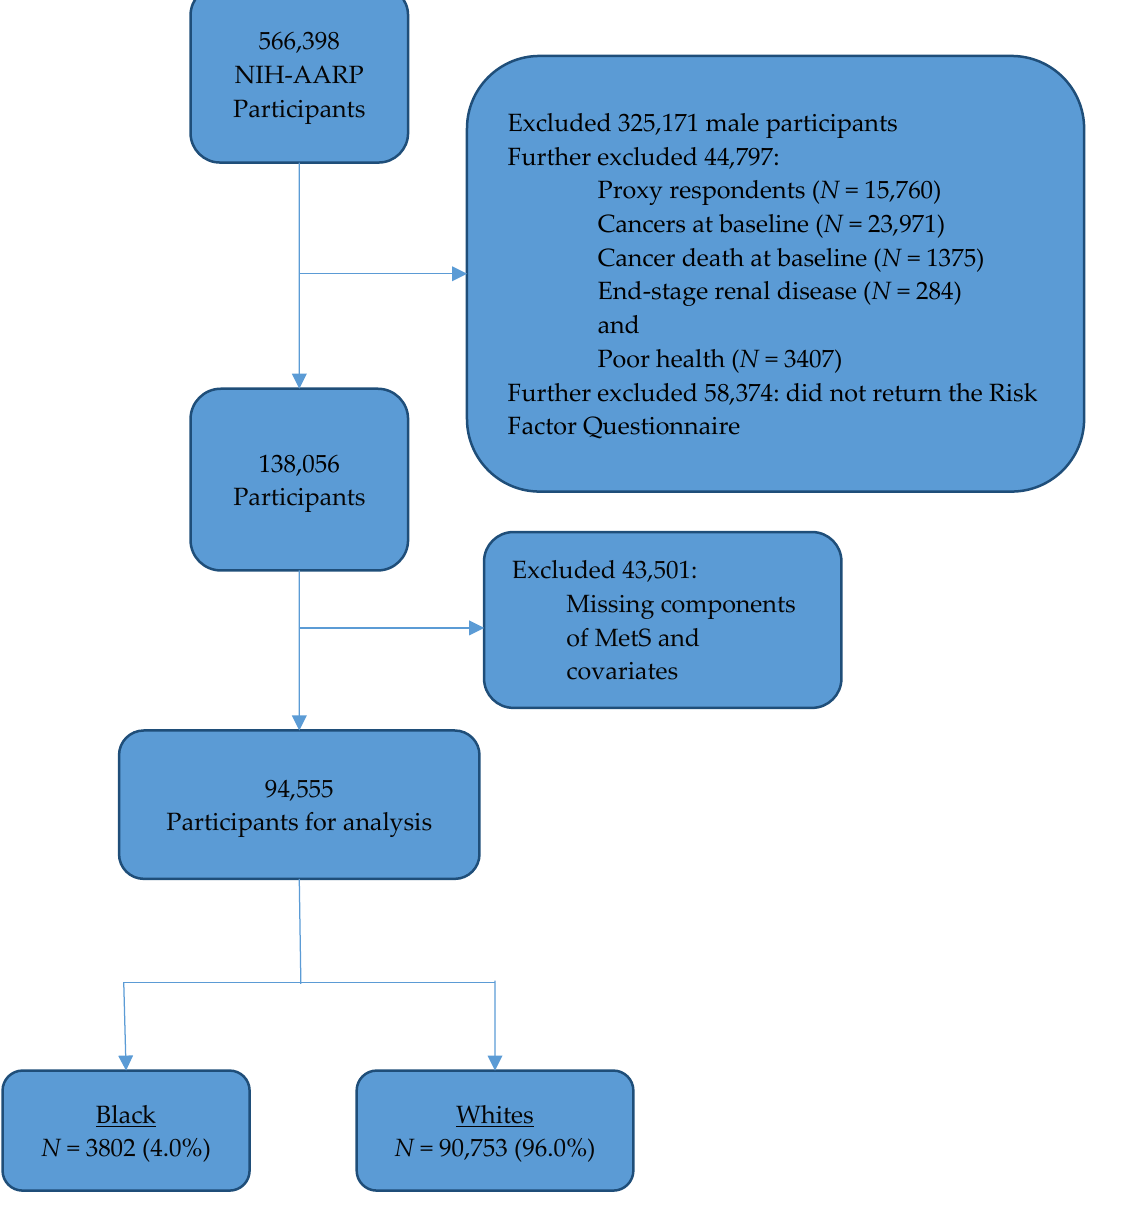
Figure 1. Participant selection process.